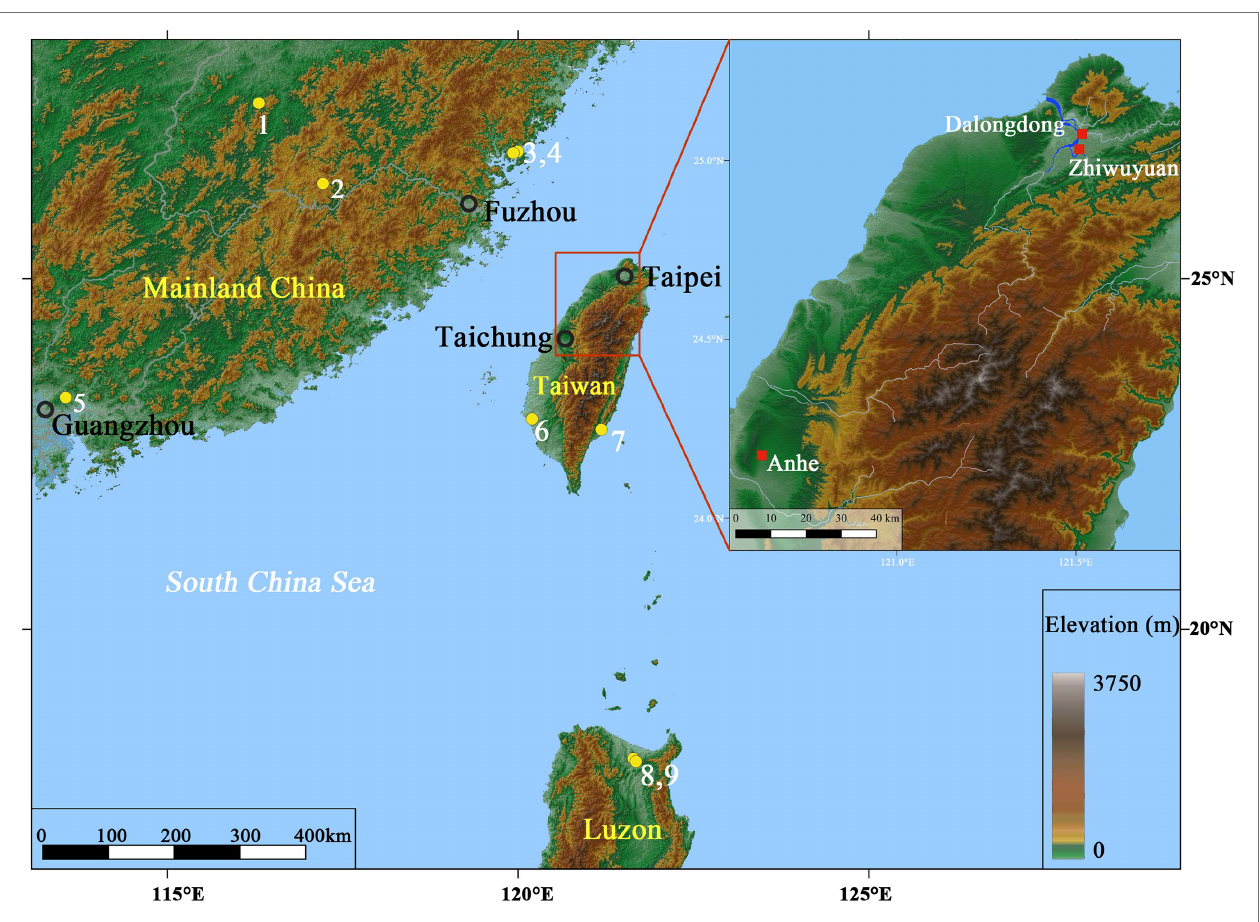
FIGURE 1 | Location of the studied sites and other main sites mentioned in this study; (1) Guodishan, (2) Nanshan, (3) Huangguashan, (4) Pingfengshan, (5) Gancaoling, (6) Nanguanlidong and Nanguanli, (7) Chaolaiqiao, (8) Nagsabaran, and (9)